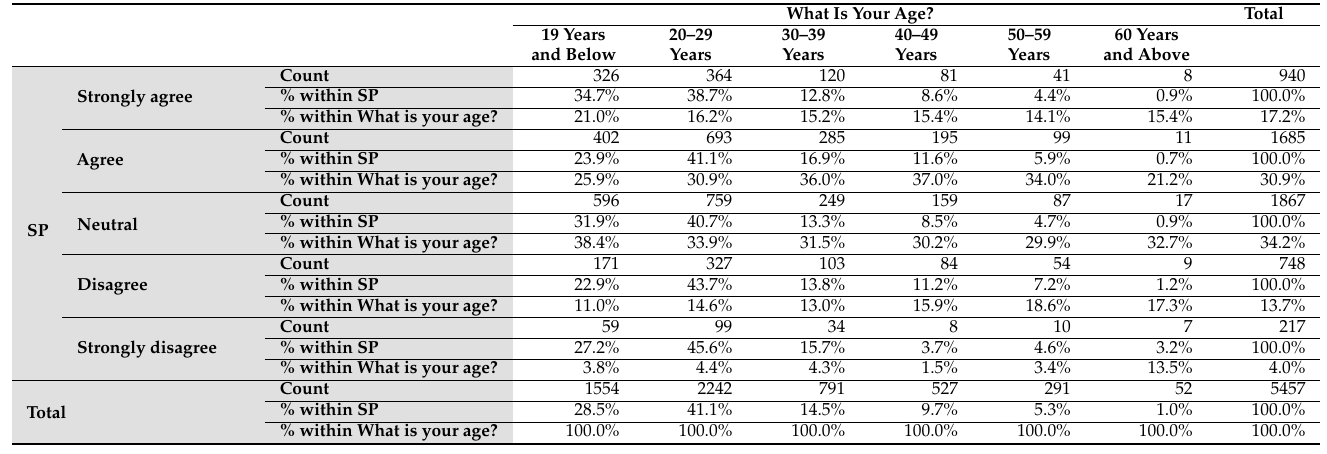
Table 18. Symbolic private value of EVs and respondents’ age cross-tabulation.